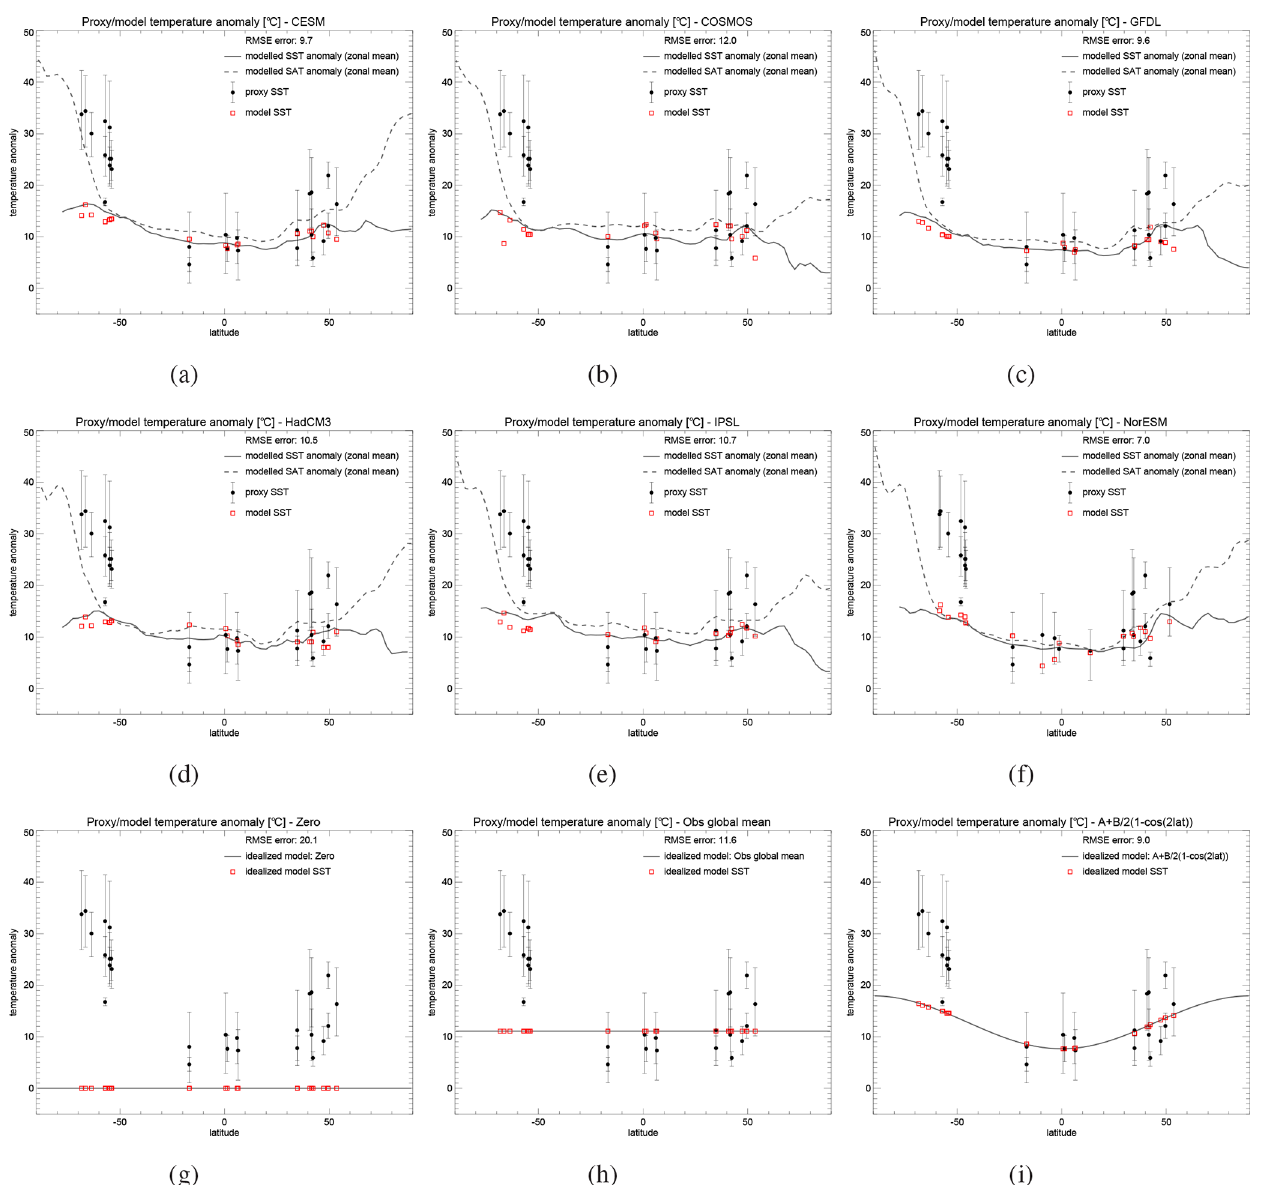
Figure 6. (a–d) Zonal mean SST (solid lines) and near-surface air temperature (dashed line) anomalies, relative to the zonal mean of the associated preindustrial simulation, for the scaled version of the (a) CESM, (b) COSMOS, (c) GFDL, (d) HadCM3, (e) IPSL, and (f) NorESM models. Also shown are the EECO SSTs and error bars from Hollis et al. (2019), expressed as a difference relative to the zonal mean of the preindustrial observations. Panels (g) – (i) are the same as panels (a) – (f) but instead of a model we show idealized temperature distributions of (g) 0, (h) C , and (i) A + B (1 − cos2 φ ). All plots also show the proxy SST estimates from Hollis et al. (2019) for the EECO, excluding those sites that they identified as being affected by diagenesis (black circles with uncertainty bars). The modelled and idealized SSTs at the specific location of the proxies (red squares) are also